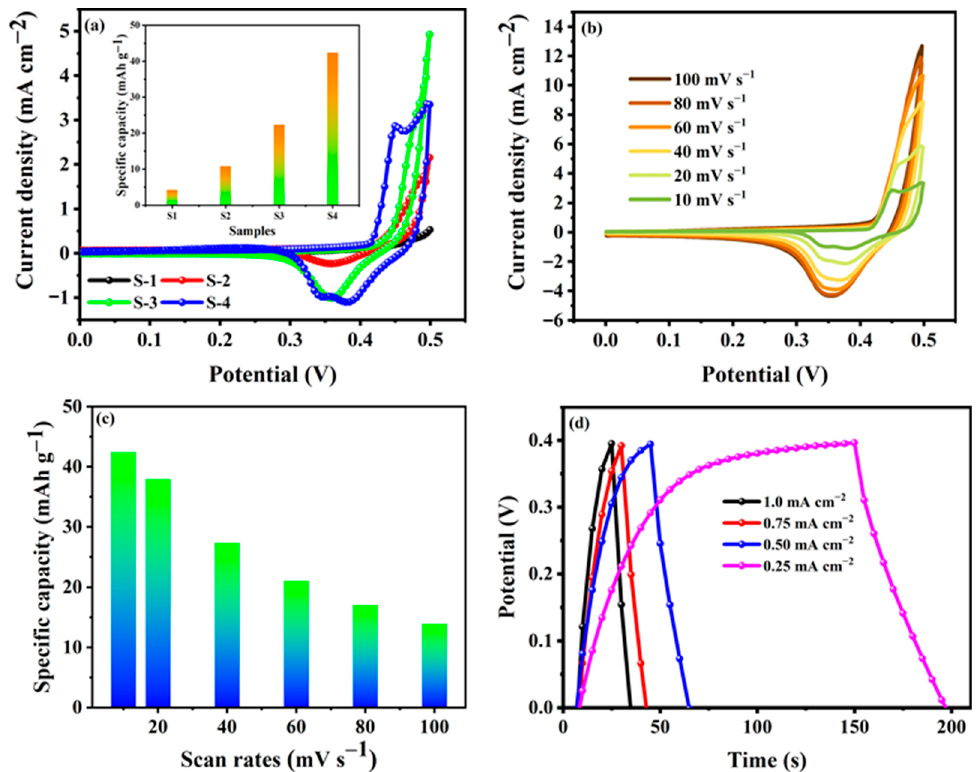
Figure 4. ( a ) Cyclic-voltammetry (CV) curves, inset shows specific capacity for samples S-1, S-2, S-3, and S-4 at 10 mV s − 1 . ( b ) CV of S-4 with respect to different scan rates in the range 10–100 mV s − 1 . ( c ) Specific capacity of S-4 with different scan rates. ( d ) Galvanostatic charge/discharge (GCD) of S-4 with different current densities.